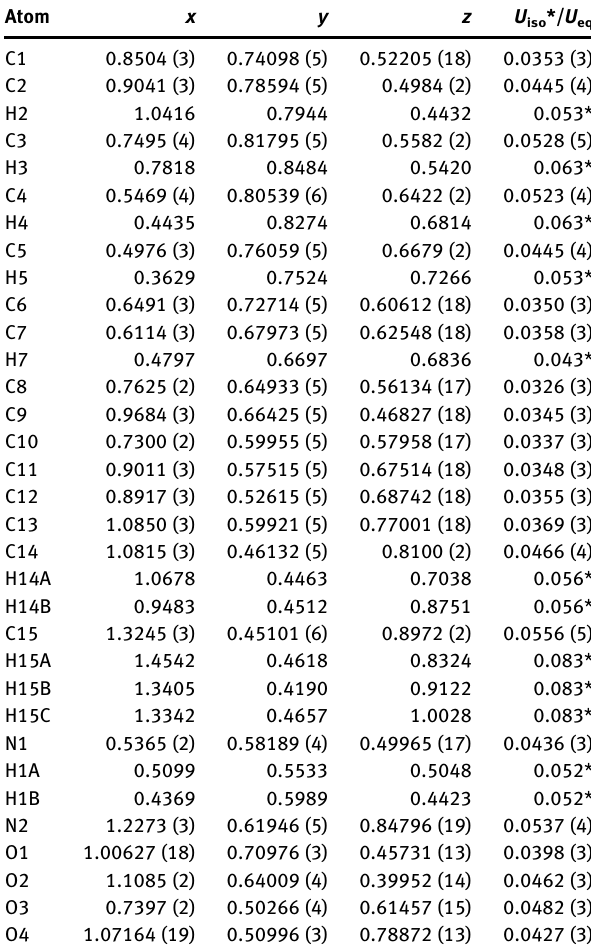
Table  : Fractional atomic coordinates and isotropic or equivalent isotropic displacement parameters (Å  ).